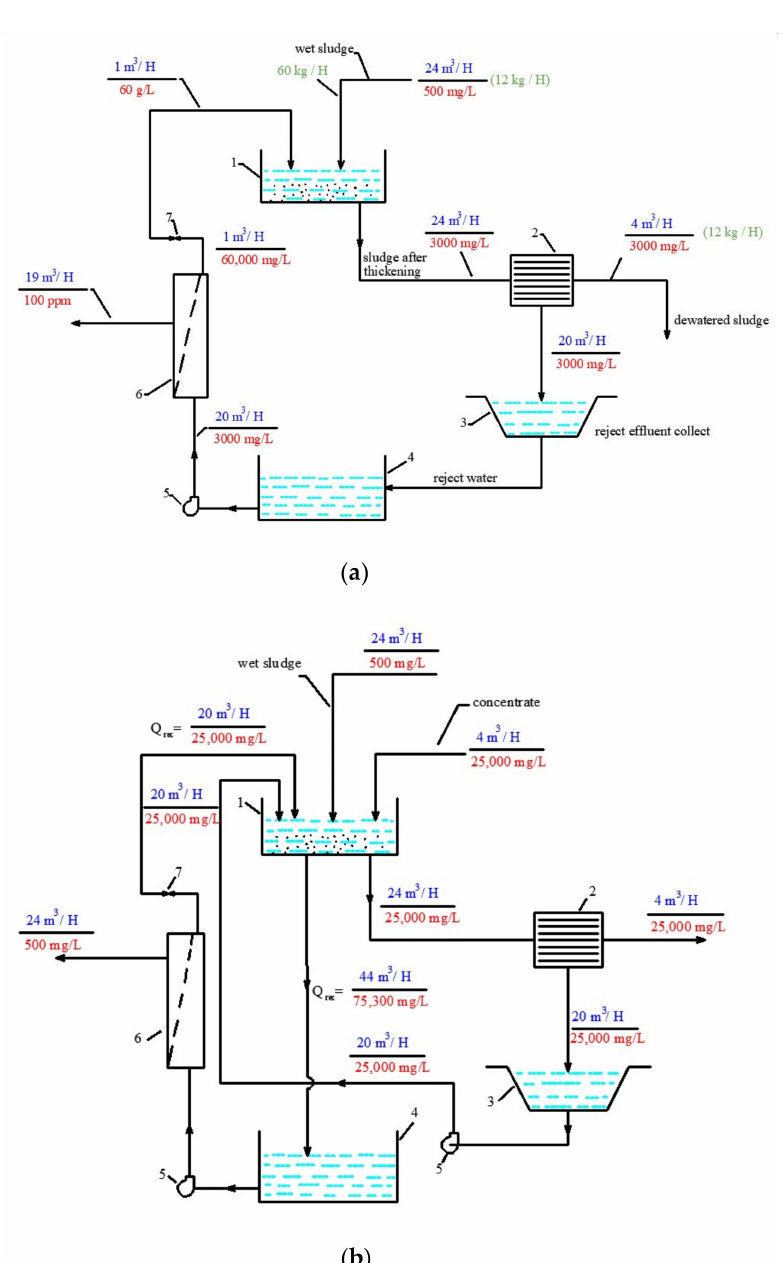
Figure 2. Water and dissolved salts balance flow diagrams of sludge dewatering, reject (fugate) and membrane concentrate disposal and utilization: ( a ) treatment of fugate after sludge dewatering using reverse osmosis and concentrate withdrawal together with dewatered sludge; ( b ) utilization of nanofiltration membrane plant concentrate together with dewatered sludge. 1—sludge thickener; 2—centrifuge; reject effluent collection tank; 3—intermediate tank; 5—working pump of reverse osmosis facility; 6—reverse osmosis membrane modules; 7—pressure regulation